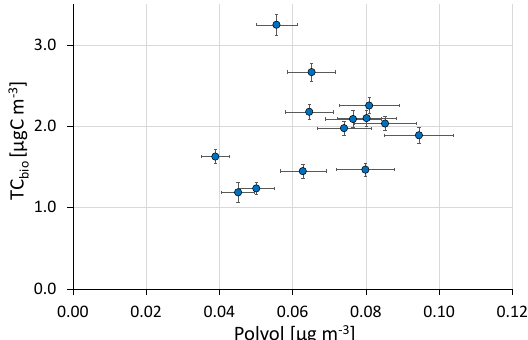
Figure 9. Comparison of TC bio based on levoglucosan and 14 C / 12 C ratio measurements against polyol concentrations. Blue dots stand for the Passy summer samples. No correlation is found between TC bio and polyol concentrations (primary biogenic emis- sions tracers). TC bio could originate from secondary organic carbon from the oxidation of biogenic